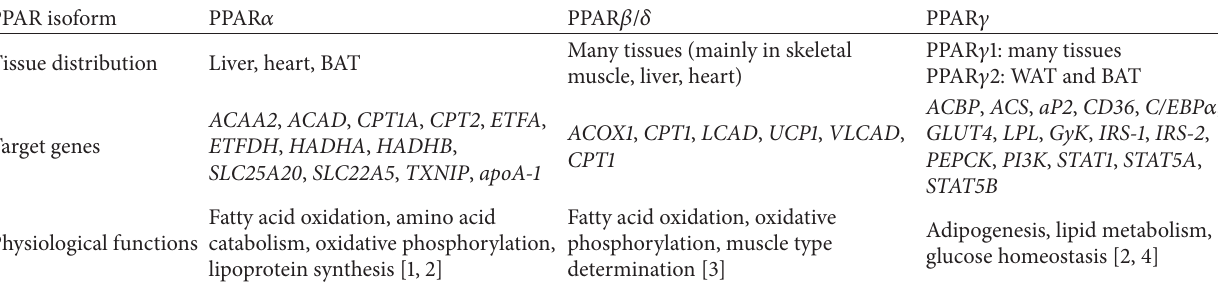
Table 1: Tissue distribution, target genes, and main functions of PPAR